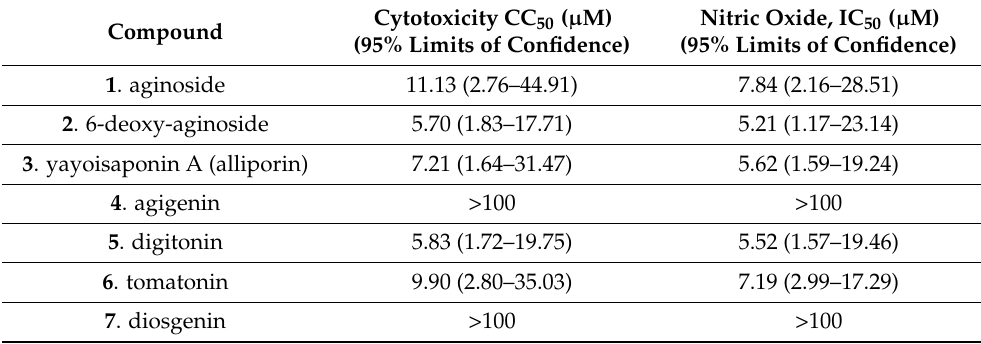
Table 1 . Concentrations required for reducing the viability of cells and NO production by 50% (CC 50 and IC 50 , respectively).